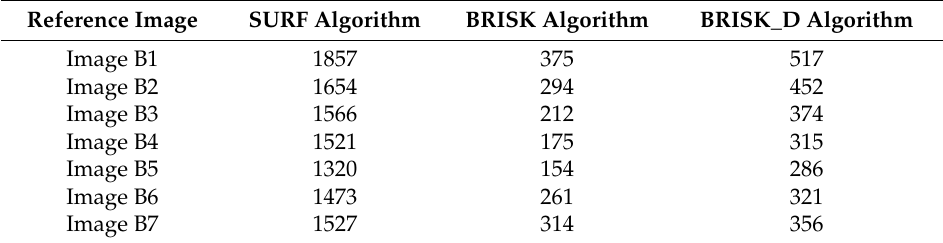
Table 6. The correct matching number of 3 algorithms after reducing the image